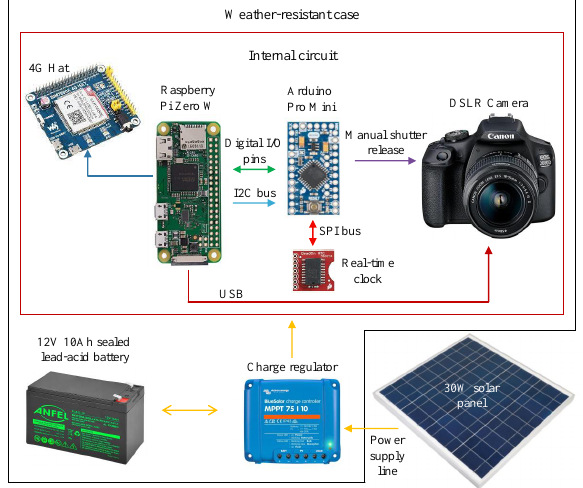
Figure 1. Scheme of the proposed acquisition system configuration for a single monitoring station. Arrows indicate the direction of signal initiation. Image adapted from Greig Sheridan (Sheridan,